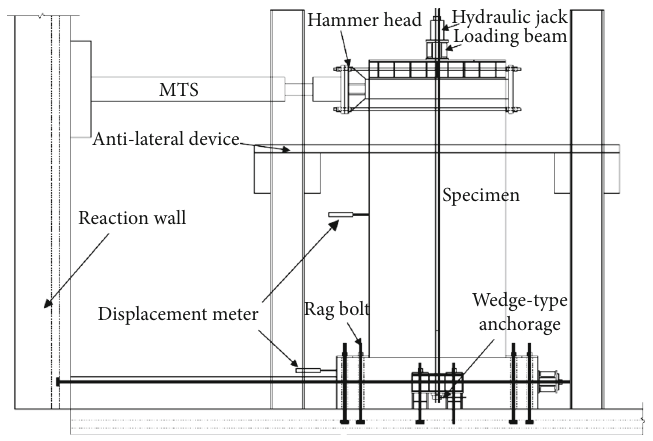
Figure 3: Test setup.